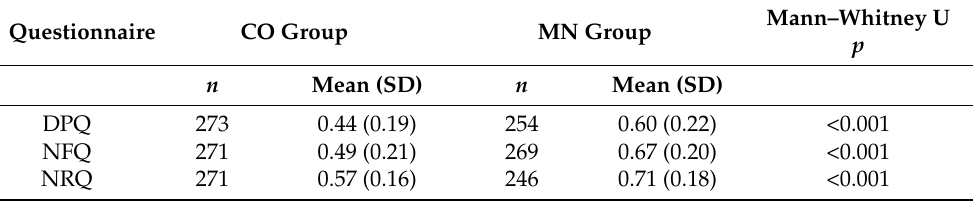
Table 3. Degree of correctness in compiling the different questionnaires. The table shows a global correctness index (proportion from 0 to 1) of answers to the Digestive process (DPQ), Nutrient function (NFQ), and Nutrient recognition (NRQ) questionnaires calculated as the ratio between the number of questions receiving the correct answers and total number of questions of the questionnaire. Questionnaire